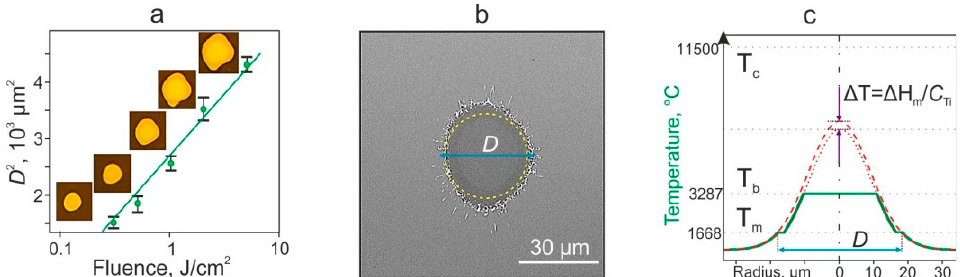
Figure 3. Effect of laser pulses on an absorbing Ti film of a donor substrate. ( a )—Dependence of the square of the hole diameter D in the Ti film of the donor slide on the laser fluence in the absence of a gel layer on the surface of the Ti film. The inserts show the corresponding optical images of the holes. Linear trend shown. ( b )—SEM image of a hole in the Ti film with melted edges when the gel layer was previously deposited on the surface of the Ti film. The yellow dotted line shows the area of the laser spot. The effective diameter of the formed hole D is shown. (F = 1 J/cm 2 ). ( c )—Green line shows the distribution of the maximum temperature in the Ti film under laser exposure in the presence of melting and vaporization of Ti. The dashed red Gaussian curve corresponds to the temperature distribution in the absence of phase transitions. The dotted red curve in the inner part of the hole corresponds to the temperature distribution in this area if vaporization of Ti does not occur. This curve is shifted down relative to the dashed curve by ∆ T due to energy expended during melting. Melting (T m ), boiling (T b ), and critical (T c ) temperatures of Ti are shown. This result is expected for a laser spot with a Gaussian intensity distribution and short pulse duration. From the Gaussian distribution of the laser fluence in the spot, it is easy to obtain the relation: D 2 ≈ 4.6 · ω 02 · lg(F/F th ), where D—diameter of the hole, ω 0 —laser beam waist radius, F—laser fluence, F th —threshold fluence for the formation of a hole in the film. According to the point of intersection of the linear trend with the axis D 2 = 0, it can be determined that F th = 0.06 J/cm 2